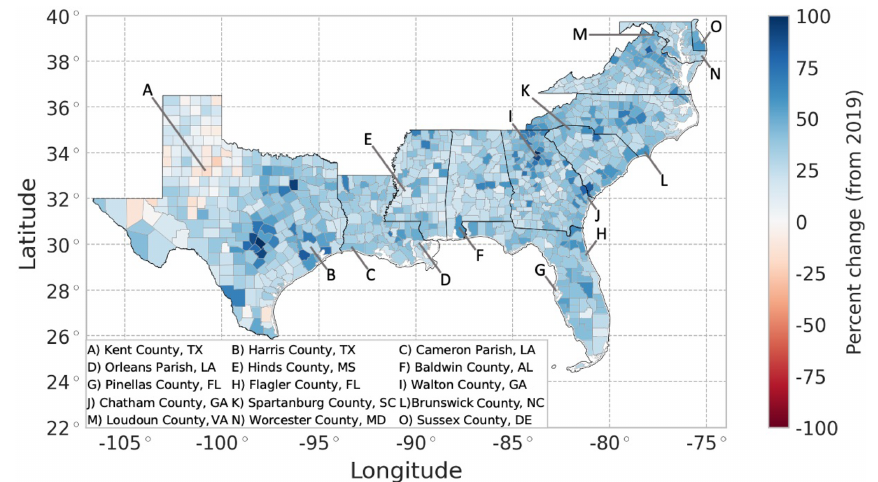
Figure 7. Projected 20-year (2019–2039) percent change in housing units using the REACH20 model. The blue color represents growth, and red represents